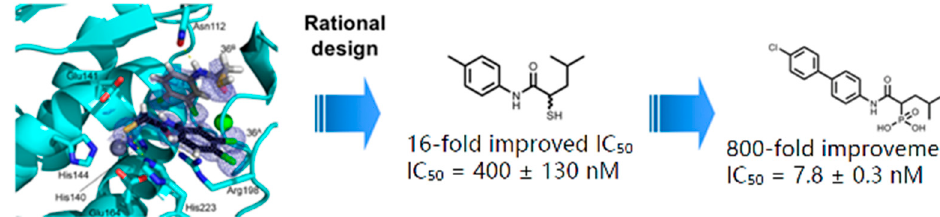
Figure 1. Structure-based optimization of LasB Figure 7. Structure-based optimization of LasB inhibitors.